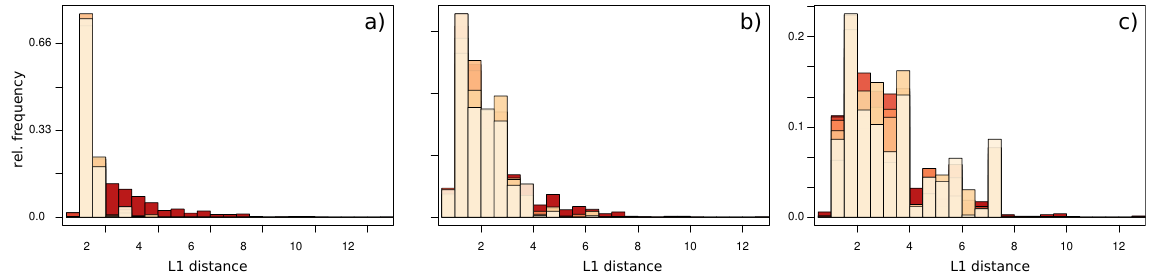
Figure 4. Draws of ADMs (by mismatch) for one perfectly dated and one time-uncertain proxy. Colors from beige (unheated) chain to red (warmest) chain. (a–c) The separation between the two proxies is 0, 750, 2084km. Compare panel (b) to Fig. 3.